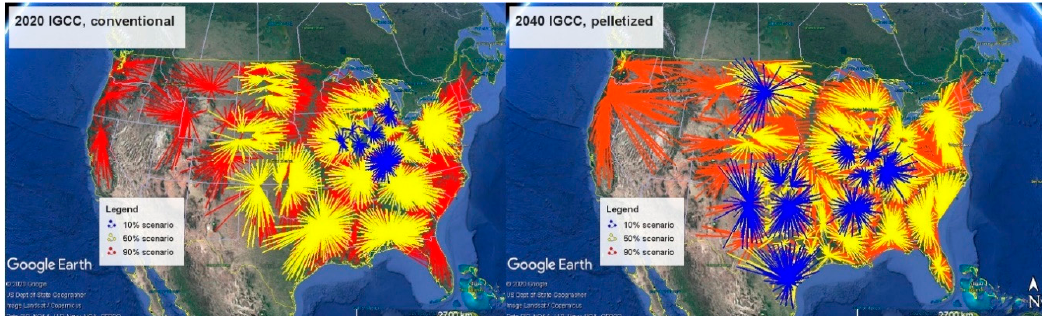
Figure 6. Illustration of county-level feedstocks allocated to potential BECCS locations under the 2040 integrated gasification combined cycle (IGCC), pelletized biomass, pulverized combustion scenario, capturing 10% (blue), 50% (yellow), and 90% (orange) of potentially sequestered CO 2 . Interactive visualizations of the other scenarios are available at https://doi.org/10.11578/1647453.